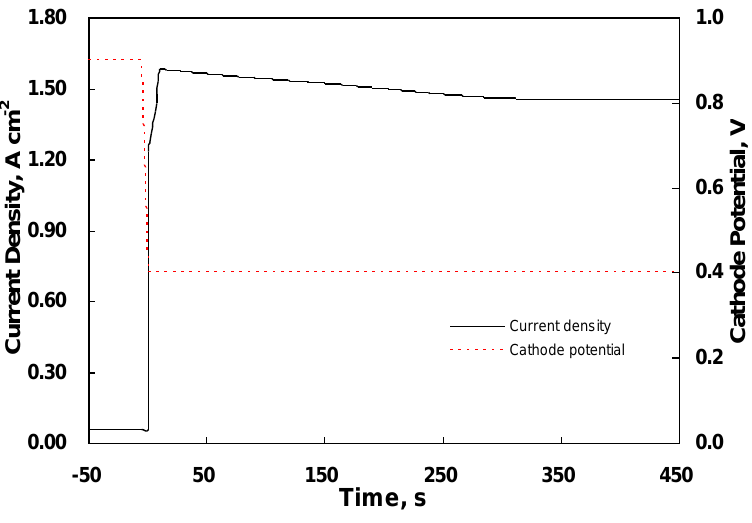
Figure 3. Current response during a step change of potential from 0.9 V to 0.4 V. Dashed line represents potential change and solid line is current